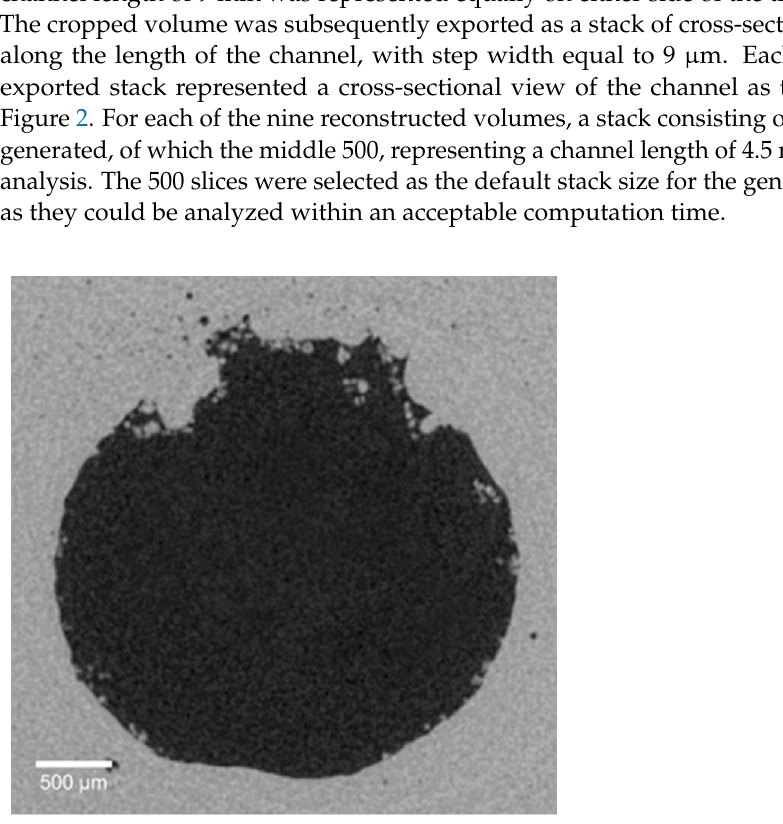
nom = 3 mm channel.